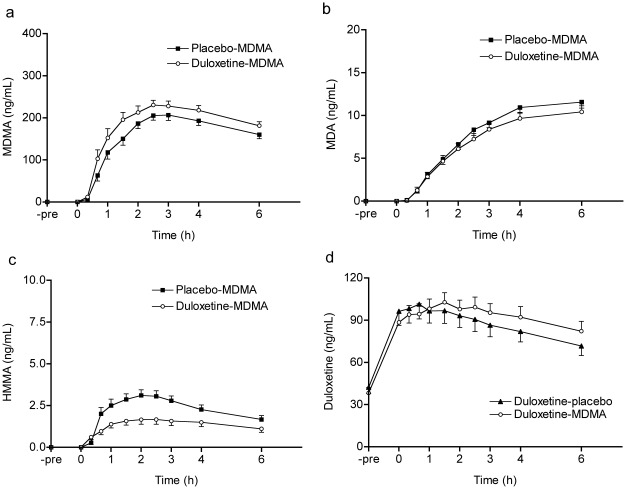
Duloxetine increased MDMA exposure.Pharmacokinetics of MDMA, MDA, HMMA, and duloxetine (a–d). Duloxetine was administered 16 h and 4 h before MDMA, which was administered at the 0 h time point. Duloxetine increased the Cmax and AUC0–6 of MDMA (a), had no significant effect on MDA exposure (b), and decreased the Cmax and AUC0–6 of HMMA (c). Plasma duloxetine concentrations were similar in the duloxetine-placebo and duloxetine-MDMA groups before MDMA administration (at –4 h and 0 h). Duloxetine concentrations increased 1 h after MDMA administration in the duloxetine-MDMA vs. duloxetine-placebo group (d). Values are expressed as mean±SEM of 16 subjects. MDMA, 3,4-methylenedioxymethamphetamine; MDA, 3,4-methylenedioxyamphetamine; HMMA, 4-hydroxy-3-methoxymethamphetamine.